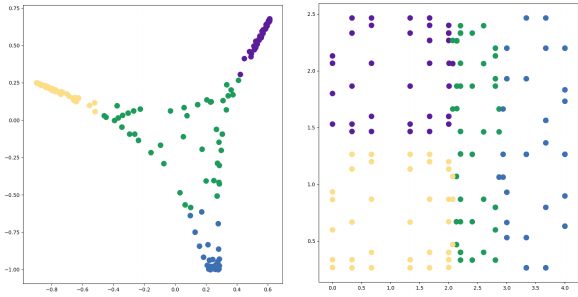
Figure 7. Result of spectral graph clustering of spectral coordinates of G as clusters in a spectral embedding (left) en the output remapped to their original positions (right).